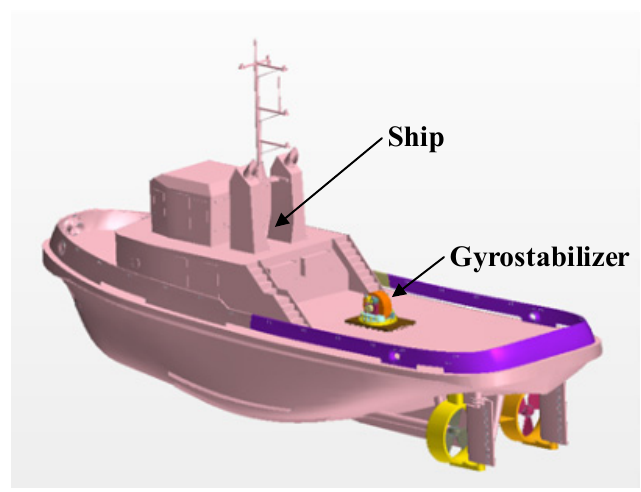
Figure 2. Physical simulation model of